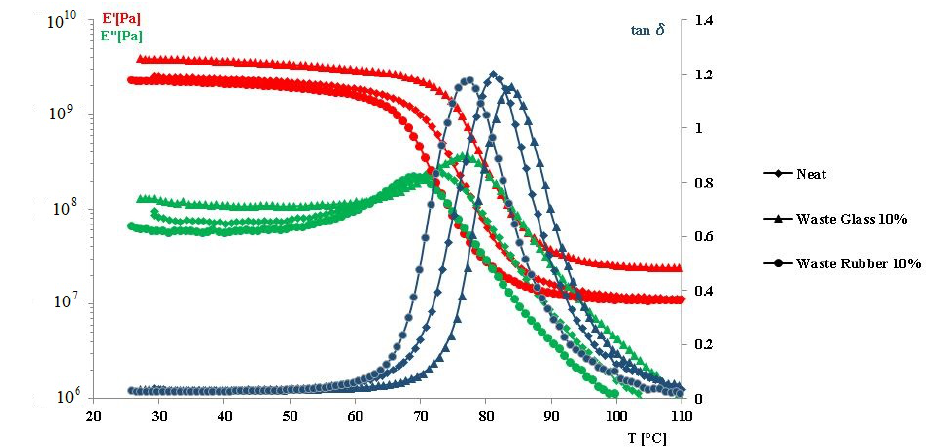
Figure 4. Sweep temperature dynamic tests: neat, waste glass 10%, waste rubber 10%. The overall results obtained from the DMTA test are reported in Table